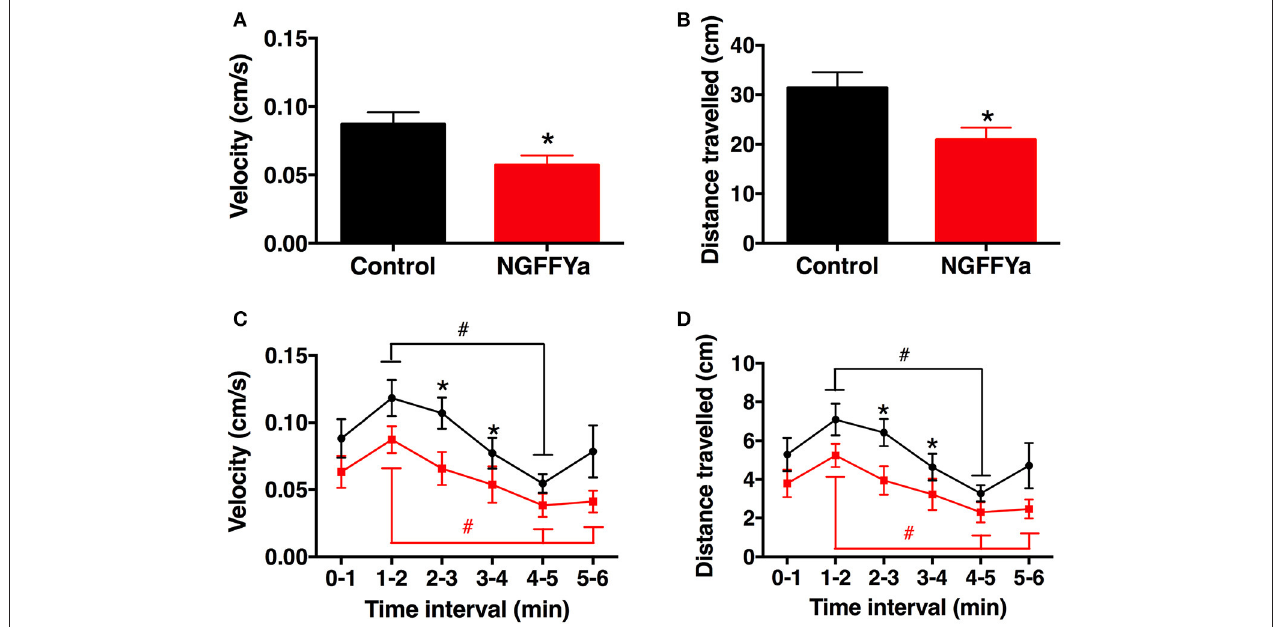
FIGURE 11 | Effects of in vivo injection of NGFFYamide on locomotor activity in A. rubens . Graphs showing (A) mean velocity (cm/s) and (B) distance traveled (cm) over an entire 6-min period, between ten-and-half minutes to sixteen-and-a-half minutes after injection with vehicle (10 µ l of distilled water; control group; shown in black) or NGFFYamide (10 µ l of 10 − 4 M NGFFYamide; shown in red). Graphs showing (C) mean velocity (cm/s) and (D) distance traveled (cm) during time intervals of 1-min over a 6-min experiment, between ten-and-half minutes to sixteen-and-a-half minutes after injection with vehicle (10 µ l of distilled water; control group; shown in black) or NGFFYamide (10 µ l of 10 − 4 M NGFFYamide; shown in red). Data are expressed as mean ± s.e.m ( n = 13 for control group; n = 14 for NGFFYamide-treated group). *Statistically significant differences ( p < 0.05) between control and NGFFYamide-treated groups, as determined by Student’s t -test (A,B) or Mann-Whitney U -test (C,D) , and #statistically significant differences determined by Kruskal-Wallis test within each group (black for control- and red for NGFFYamide-treated group; p <